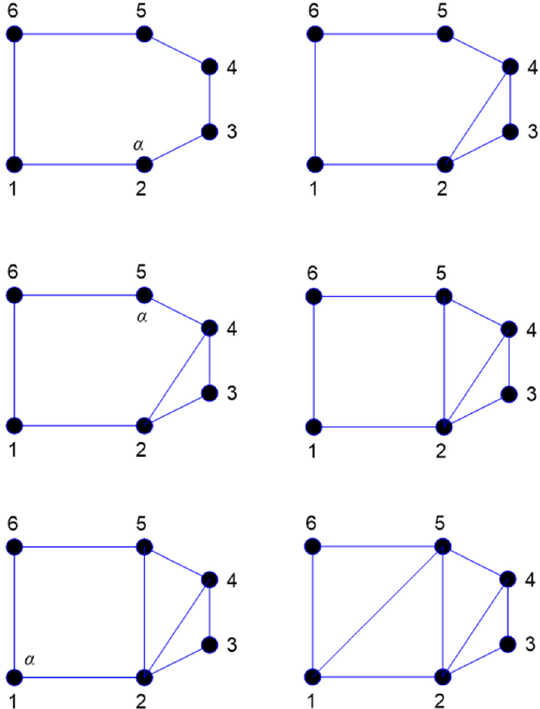
Figure 2. Polygon division using the proposed dichotomy approach.